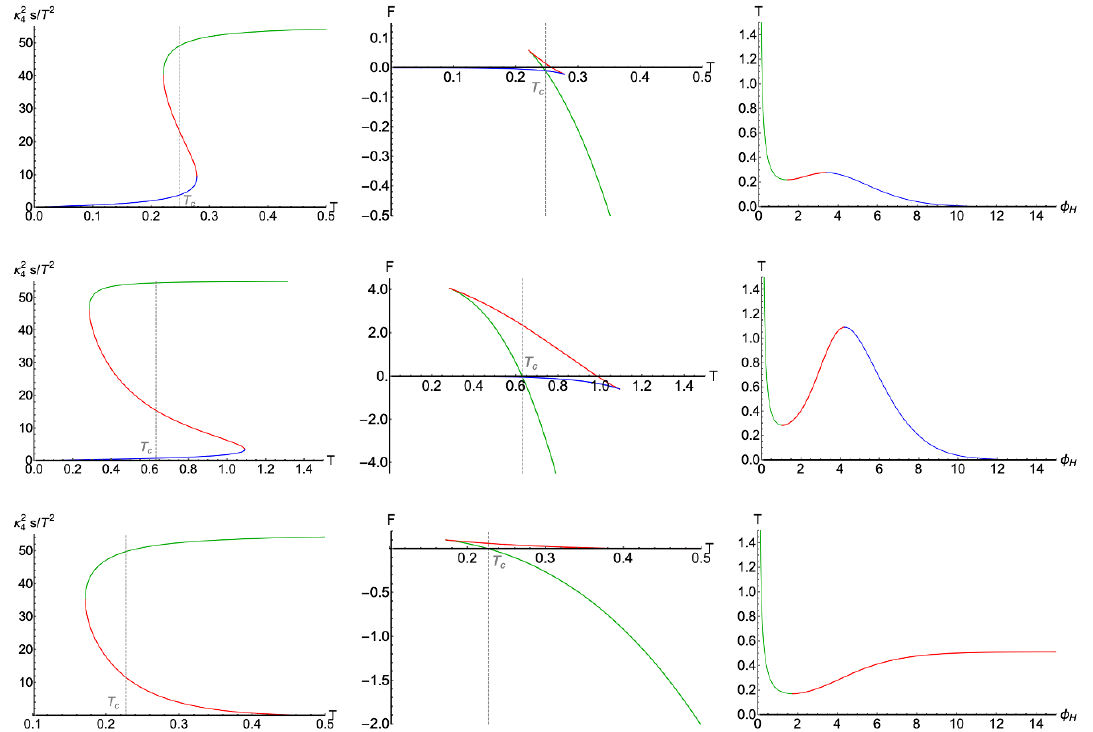
Figure 1 . Equations of state for potentials of classes A (top panels), B (middle panels), C (bottom panels). The Bekenstein-Hawking entropy density (left panels) are given by the horizon area and the free energy (middle panels) are computed using the thermodynamic relation of eq. (3.7). In the right panels we show the Hawking temperature as function of horizon scalar (cid:12)eld value. Green and blue lines represent respectively high and low temperature stable states, while red segments correspond to unstable regions. In all cases the free energy of thermal gas is set to zero. Note that in A and B classes the thermal gas is not a favourable solution at any temperature and there is no Hawking-Page phase